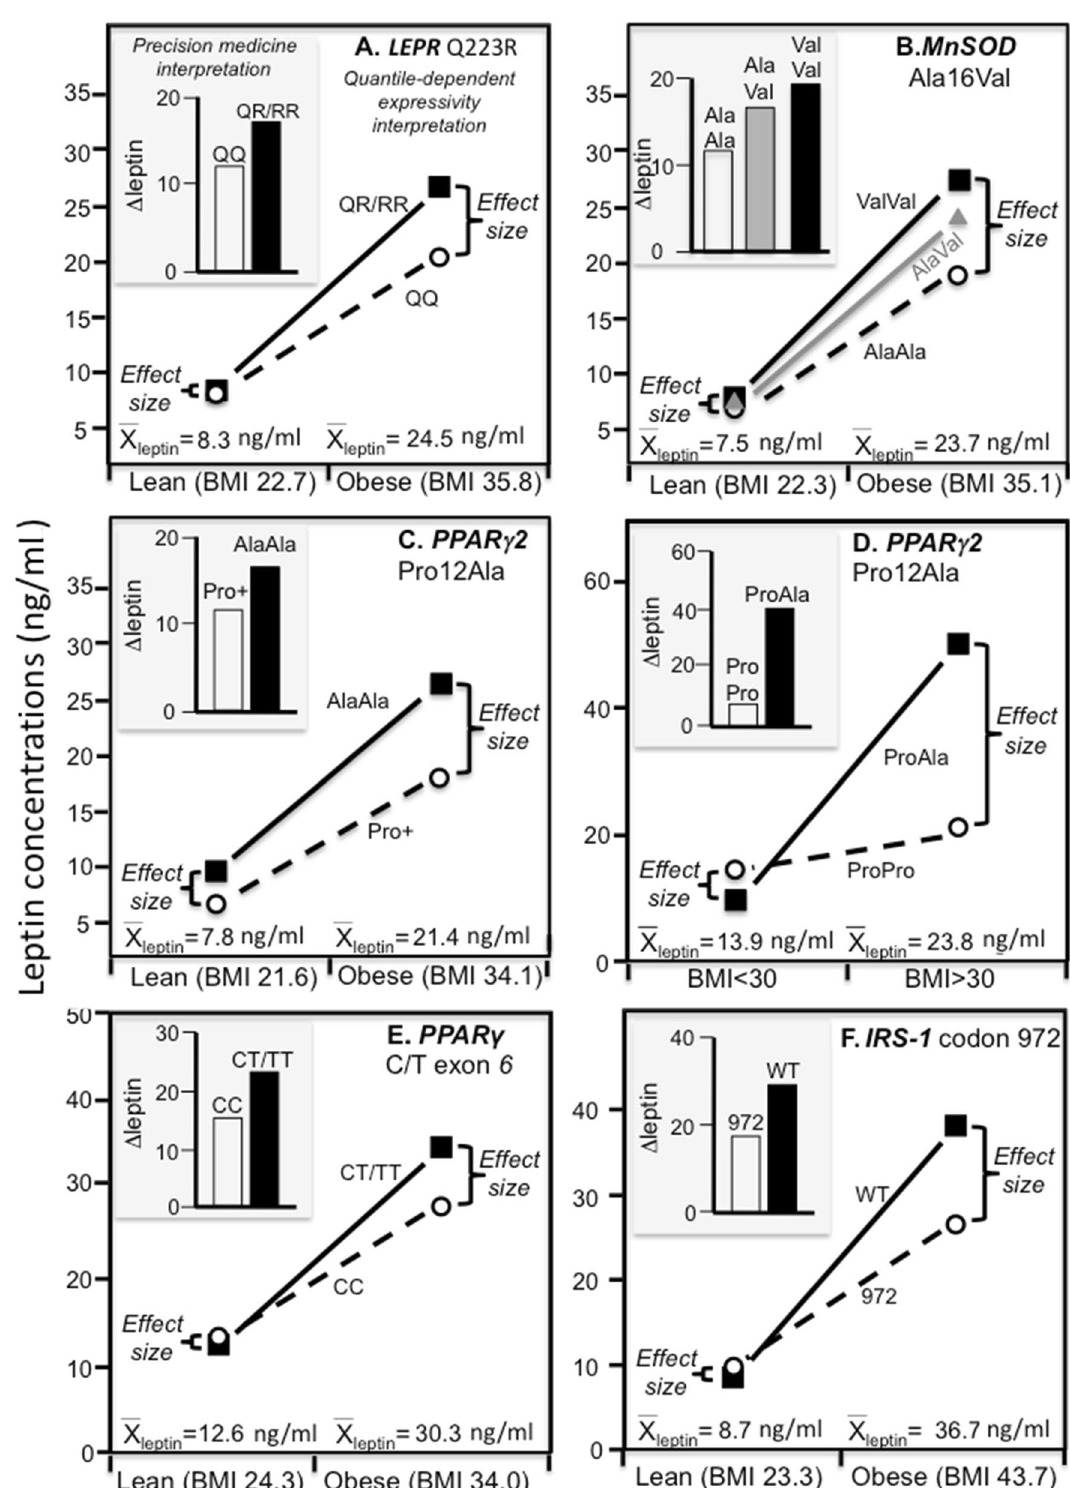
Figure 6. Precision medicine perspective of genotype-specific effects of obesity on leptin concentrations (histogram inserts) versus a quantile-dependent expressivity perspective (line graphs showing larger genetic effect size at higher average leptin concentrations) in: ( A ) QQ-homozygotes and R-allele carriers of the leptin receptor ( LEPR ) Q223R polymorphism (P interaction = 0.05) reported by Becer et al. 42 ; ( B ) AlaAla-homozygotes versus AlaVal-heterozygotes ( P = 0.03) and ValVal-homozygotes ( P = 0.0001) of the manganese superoxide dismutase ( MnSOD ) Ala16Val polymorphism reported by Becer et al. 43 ; ( C ) AlaAla-homozygotes vs Pro-allele carriers of the peroxisome proliferator-activated receptor γ2 ( PPARγ2 ) Pro12Ala polymorphisms (P interaction = 0.03) reported by Becer et al. 41 ; ( D ) PPARγ2 Pro12Pro-homozygotes vs Pro12Ala T2DM patients (P interaction = 0.03) reported by Simon et al. 40 ; ( E ) CC-homozygotes vs T-allele carriers of the peroxisome proliferator-activated receptor γ ( PPARγ ) C/T exon 6 polymorphism (P interaction = 0.03) reported by Meirhaeghe et al. 44 ; ( F ) 972-variant vs wild type at codon 972 of the insulin receptor substrate-1 (IRS-1) polymorphism reported by Krempler et al. 45